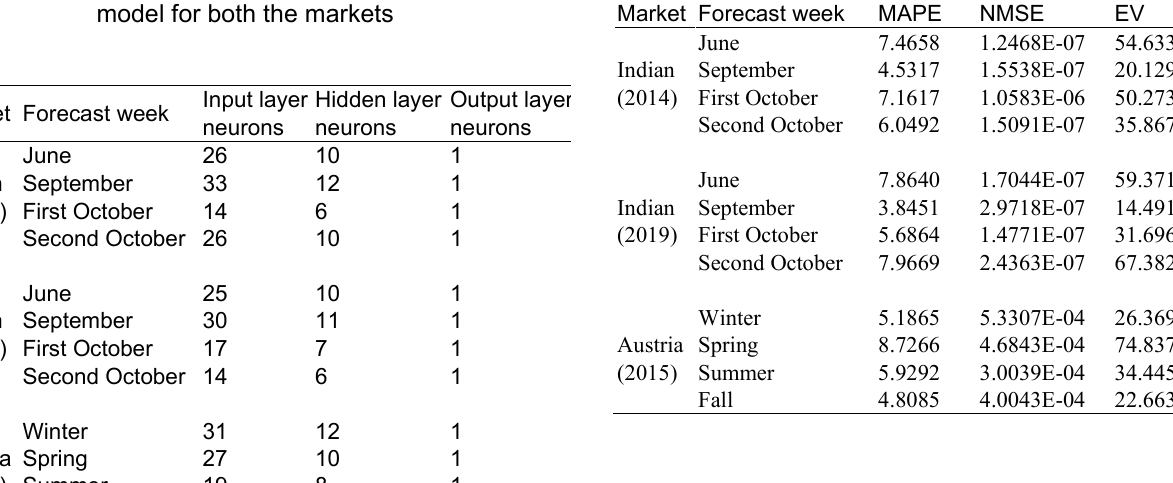
Table 2. Statistical analysis for the four weeks of Indian and Austria energy exchange